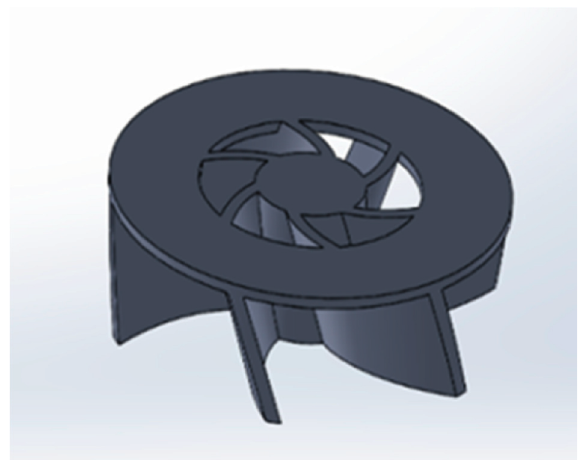
Figure 1: Impeller 3D model.